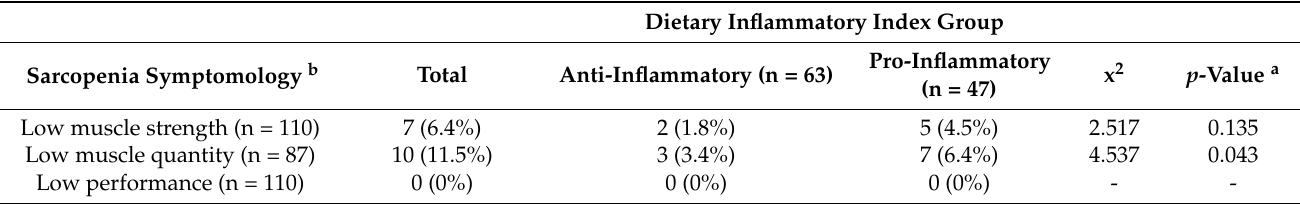
Table 2. Participants presenting with low muscle strength, quantity and physical